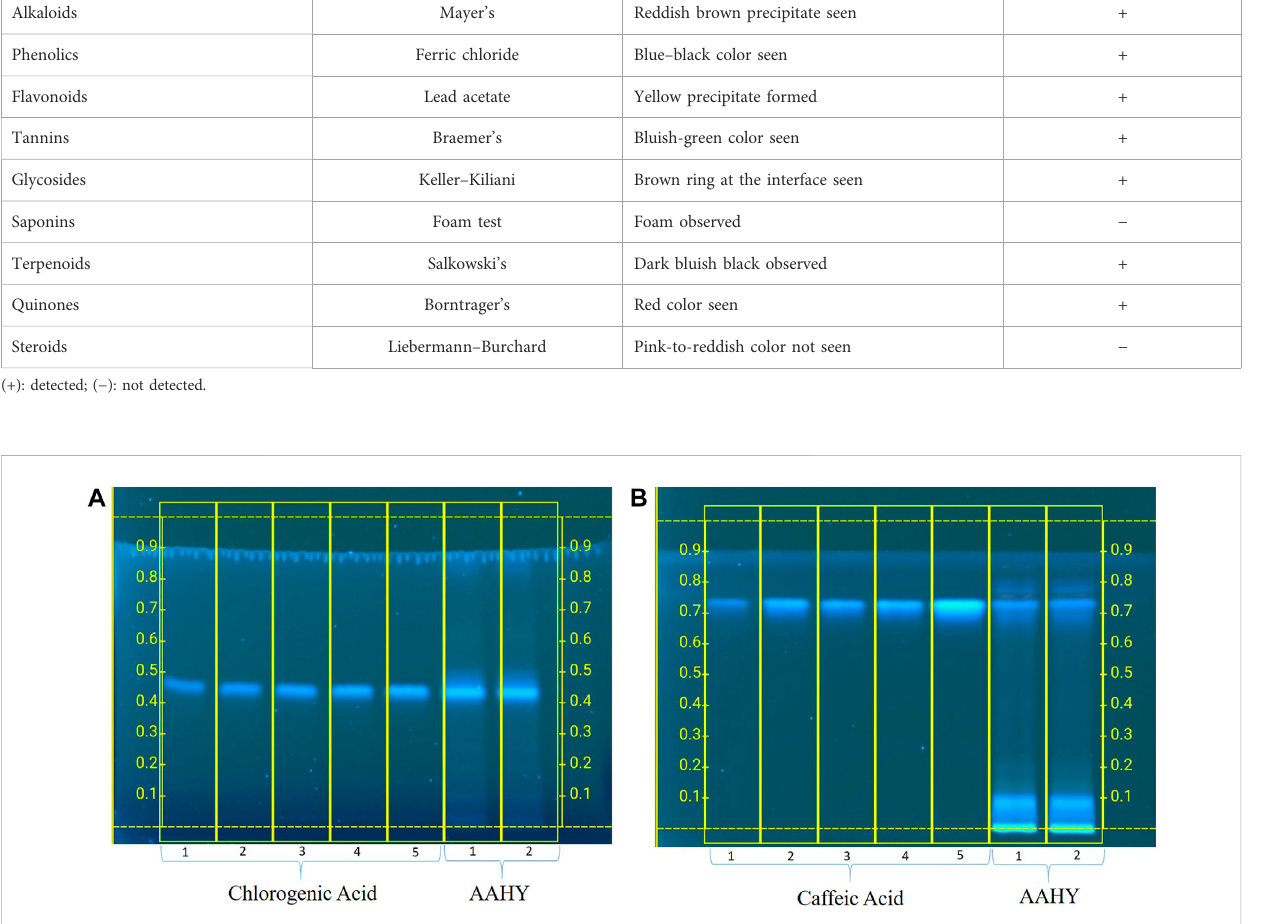
FIGURE 1 Standardization of the AAHY extract for the presence of (A) chlorogenic acid and (B) caffeic acid as the standard phytomarker through HPTLC analysis.